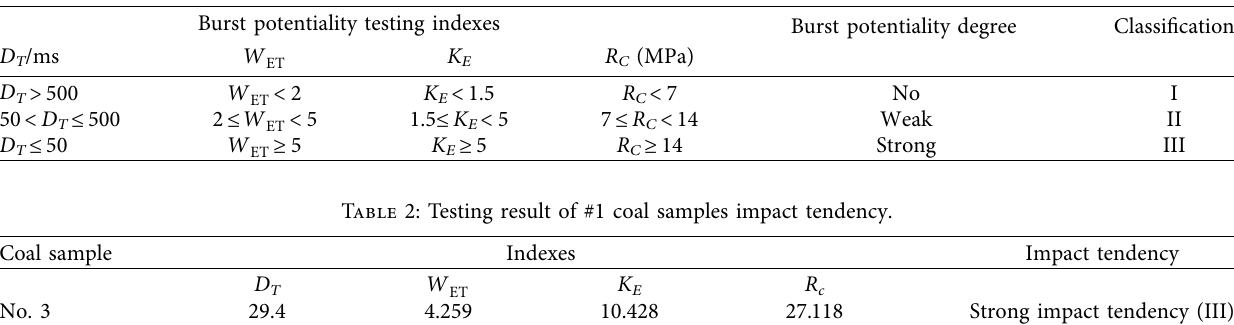
Figure 1: No. 705 fully mechanized working face Table 1: The critical index values of burst potentiality about coal seam.